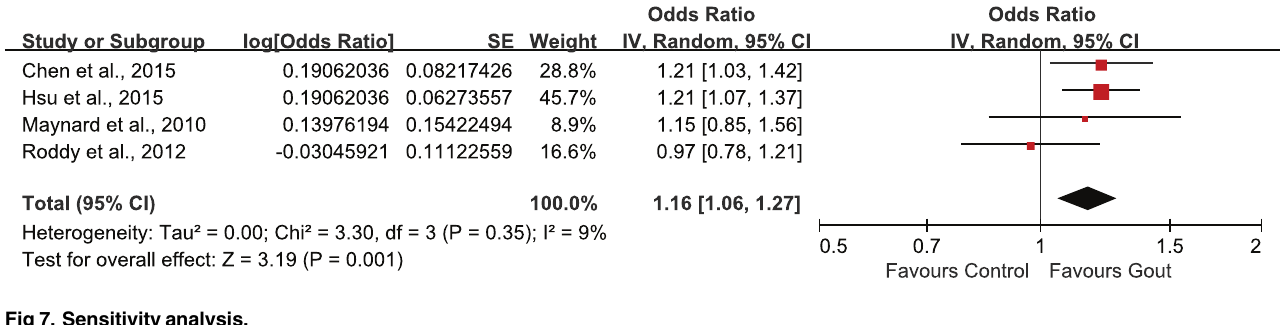
Fig 7. Sensitivity